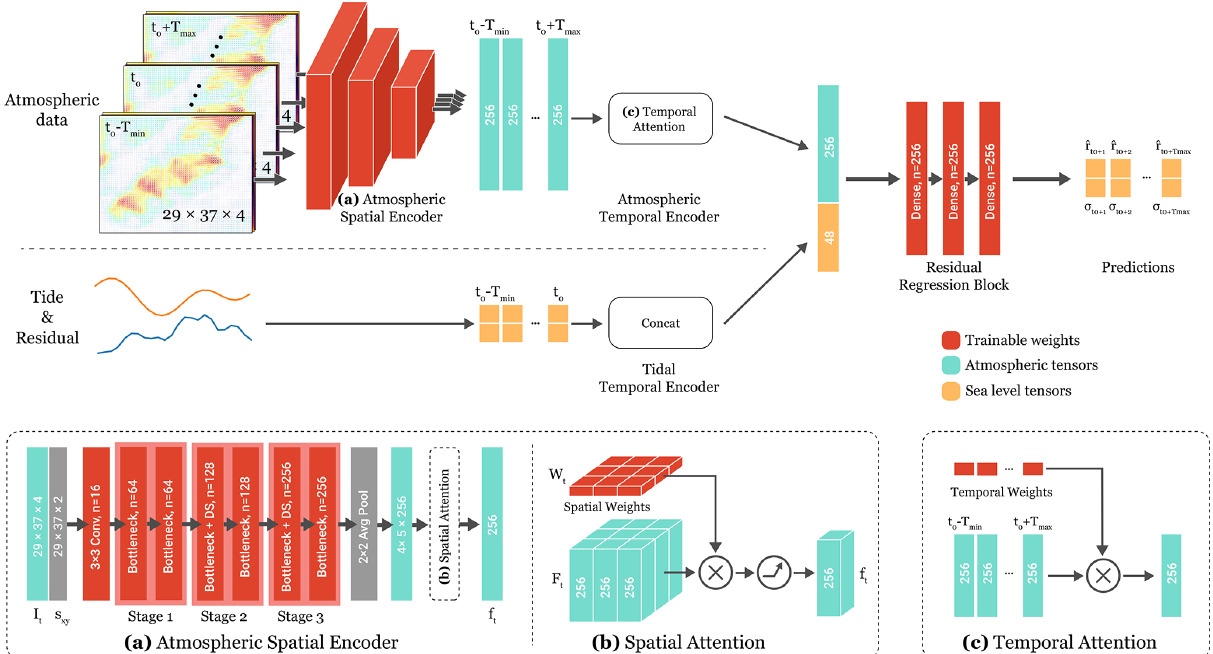
Figure 3. The proposed HIDRA architecture. A convolutional atmospheric spatial encoder (ASE) extracts spatial atmospheric features from each time step. Atmospheric and sea level temporal features are encoded by respective temporal encoder blocks, fused and passed to the fully connected residual regression block to predict the residuals along with their uncertainties. With n we denote the number of filters or units of the block. The trainable blocks are coloured red. The structure of the bottleneck blocks used in the ASE is presented in Fig. 4.